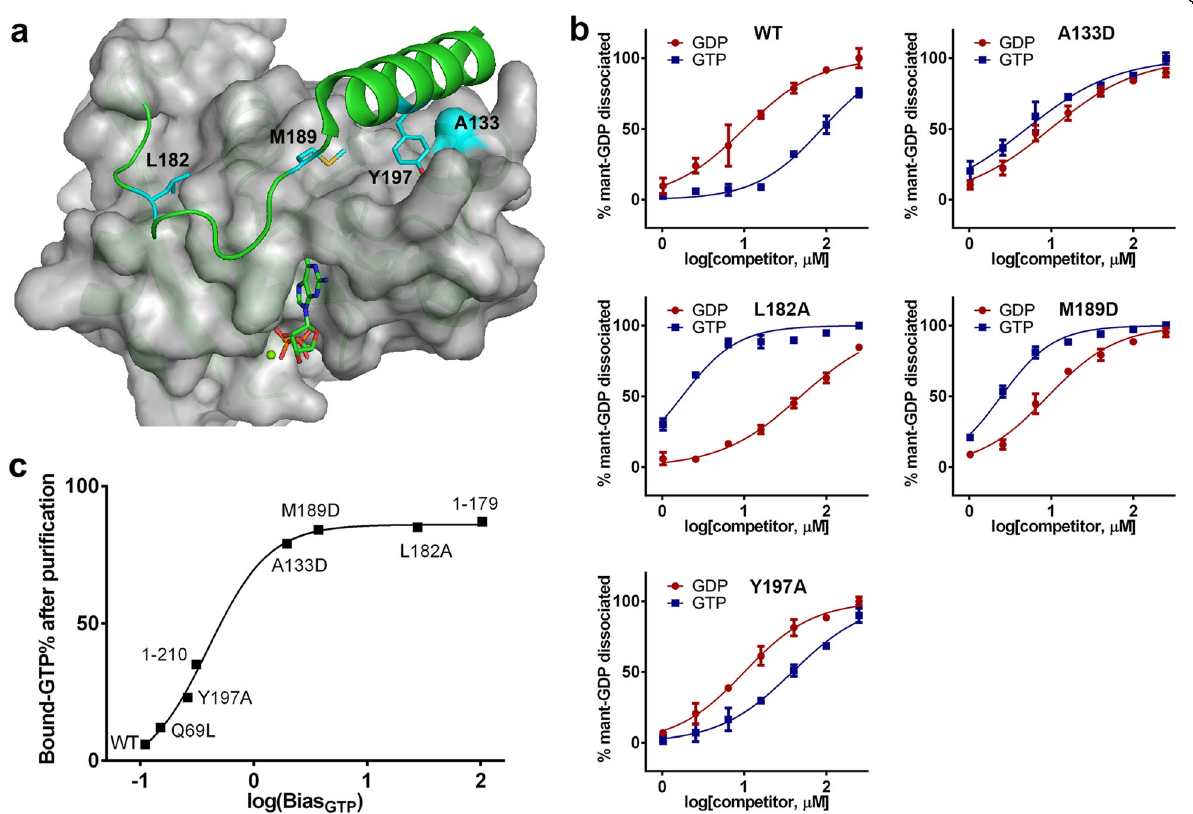
Fig. 1 Higher GTP binding preference of Ran C-dis mutants. a Illustration of the mutation sites. Ran (3GJ0) is displayed as a green cartoon with the G-domain covered in a partially transparent grey surface. Four loci of mutagenesis (L182, M189, Y197, and A133) are shown as cyan surfaces. GDP is shown as sticks. b mant-GDP dissociation by different concentrations of GDP or GTP. Error bars represent standard deviations of triplicates. IC50 values are shown in Table 1. c Correlation between GTP% values (Supplementary Table 1) and GTP binding preference (Bias GTP from Table 1, shown on a log scale). The Pearson correlation coefficient (CC) is 0.9. The line represents four-parameter logistic regression of the